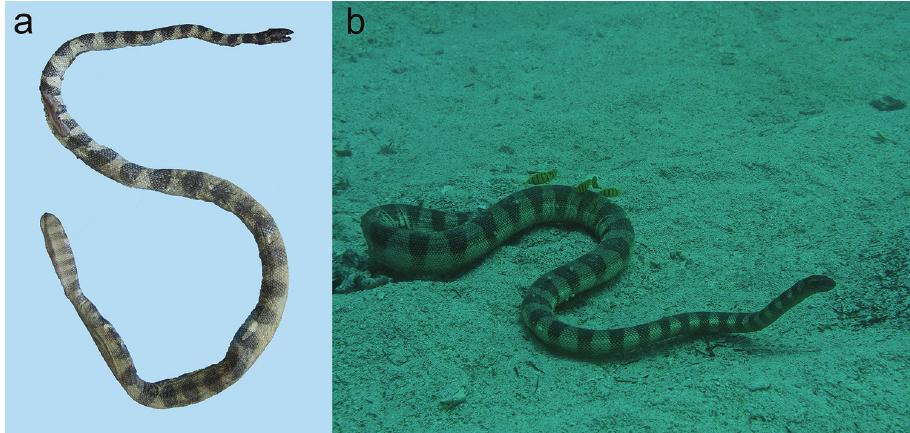
Figure 22. Hydrophis lapemoides : a body of a specimen examined in this study b living individual in coastal waters of Abu Dhabi, UAE, eastern Persian Gulf, depth 10 m, June 2015 (photographed by Rima W.